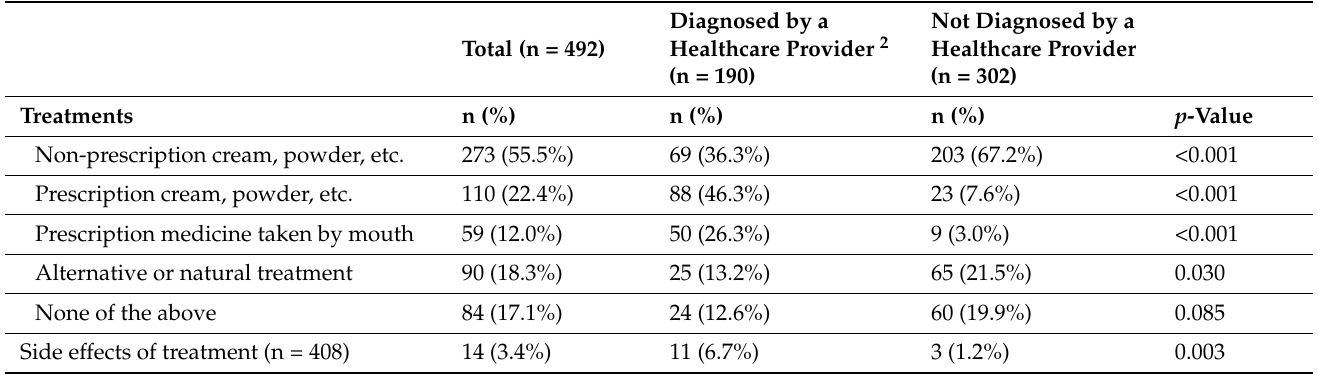
Table 2. Treatments for and complications of superficial fungal infections (ringworm and fungal